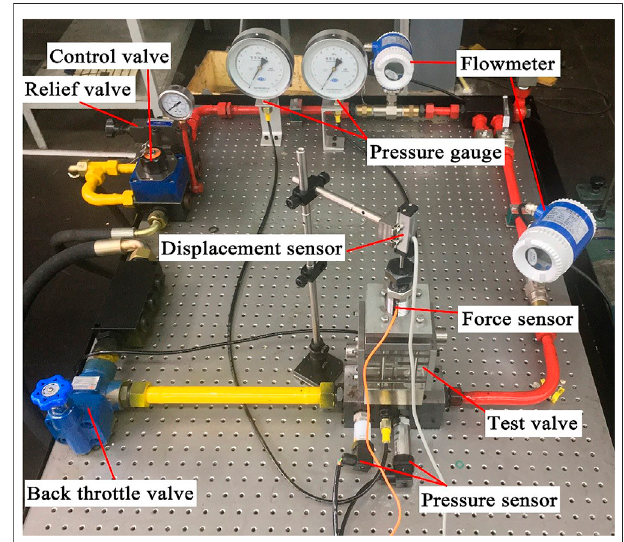
FIGURE 5 | Comparison of experimental results of various factors.